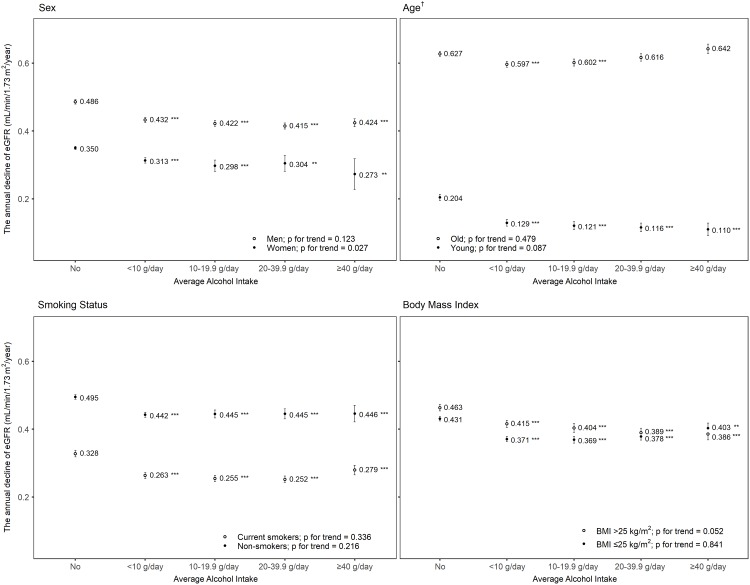
The association between alcohol intake and the annual decline of estimated glomerular filtration rate (eGFR).The estimated mean of decline change in eGFR was calculated with a generalized linear model adjusted for baseline characteristics; age, sex, body mass index, systolic blood pressure, fasting serum glucose, serum high-density lipoprotein cholesterol and triglycerides levels, history of diabetes and hypertension medication, regular exercise, and smoking status. Dots and error bars represent the estimated mean of the annual decline in eGFR and 95% confidence interval, respectively. * p<0.05 compared with non-drinkers, ** p<0.01, *** p<0.001, and † old group older than the sex-specific median age (44 years in men and 48 years in women).